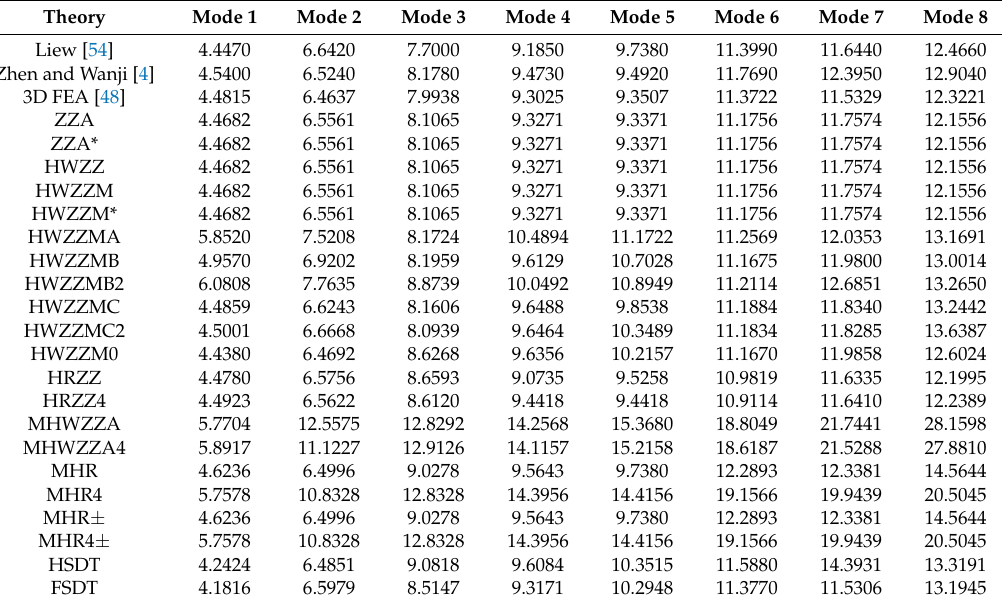
Table 15. Normalized fundamental frequencies, case